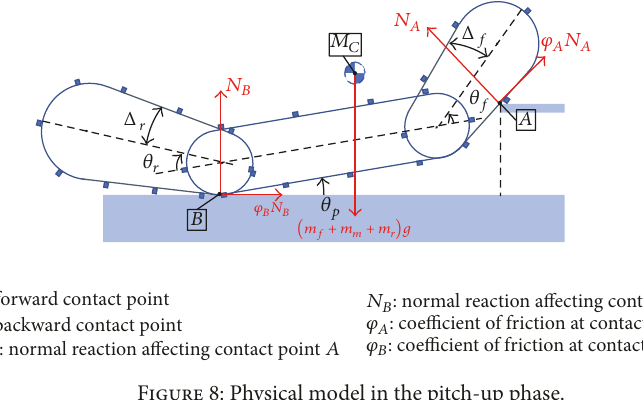
Figure 8: Physical model in the pitch-up